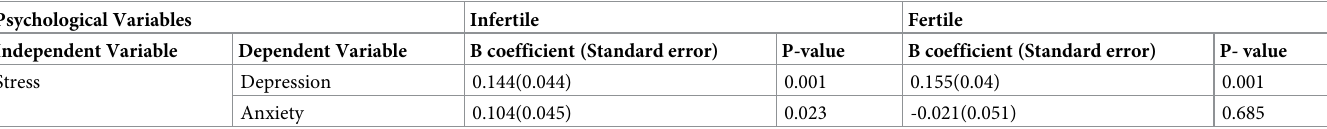
Table 7. Association of stress with other psychological variables among fertile and infertile women. Psychological